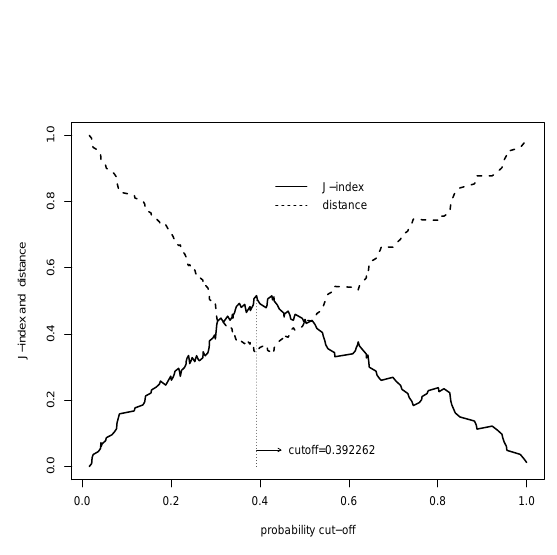
Figure 4 – Plot of Youden’s J statistic and d (top-left corner distance) versus all possible probability cut-off points.